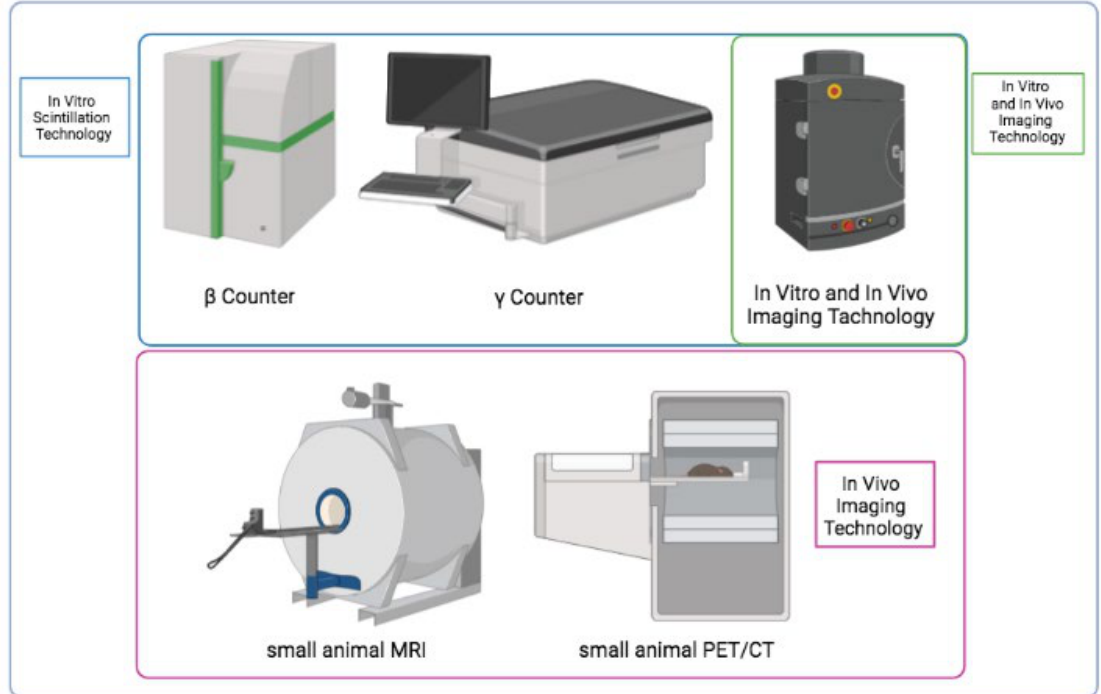
Figure 3. In vitro and in vivo systems for preclinical evaluation of radiopharmaceuticals.